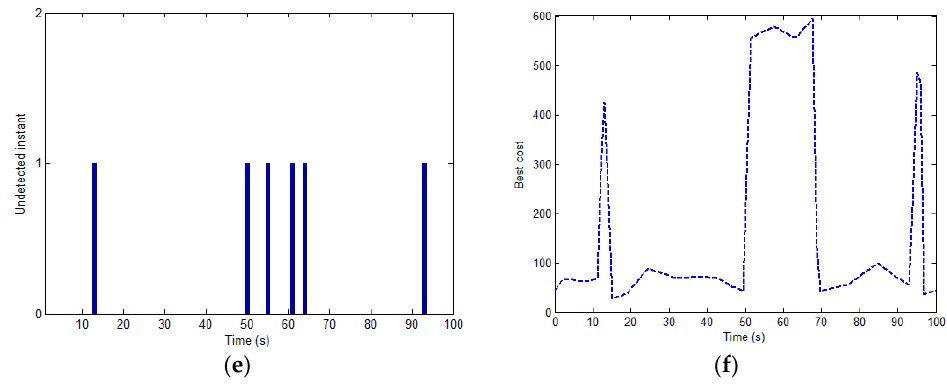
Figure 7. The performance of the proposed method for scenario 2. ( a ) 3D view of the planned path for each UAV; ( b ) Top view of the resulting paths; ( c ) The relative distance among each UAV during tracking; ( d ) The roll-command for each UAV ( e ) The undetected time-instant; ( f ) The total cost of the tracking process.